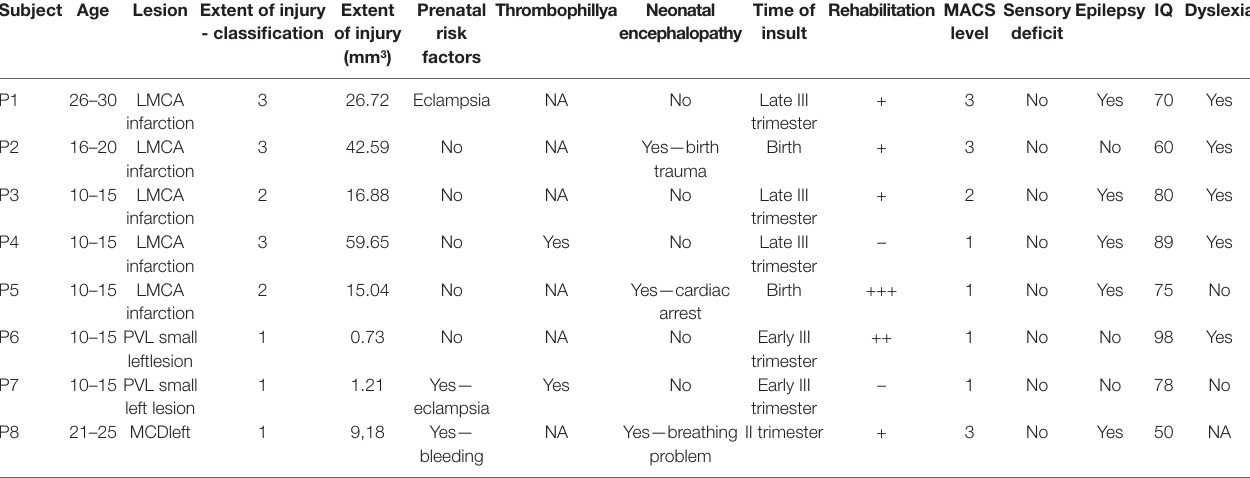
TABlE 1 | Demographic and clinical data of patients. subject Age lesion Extent of injury